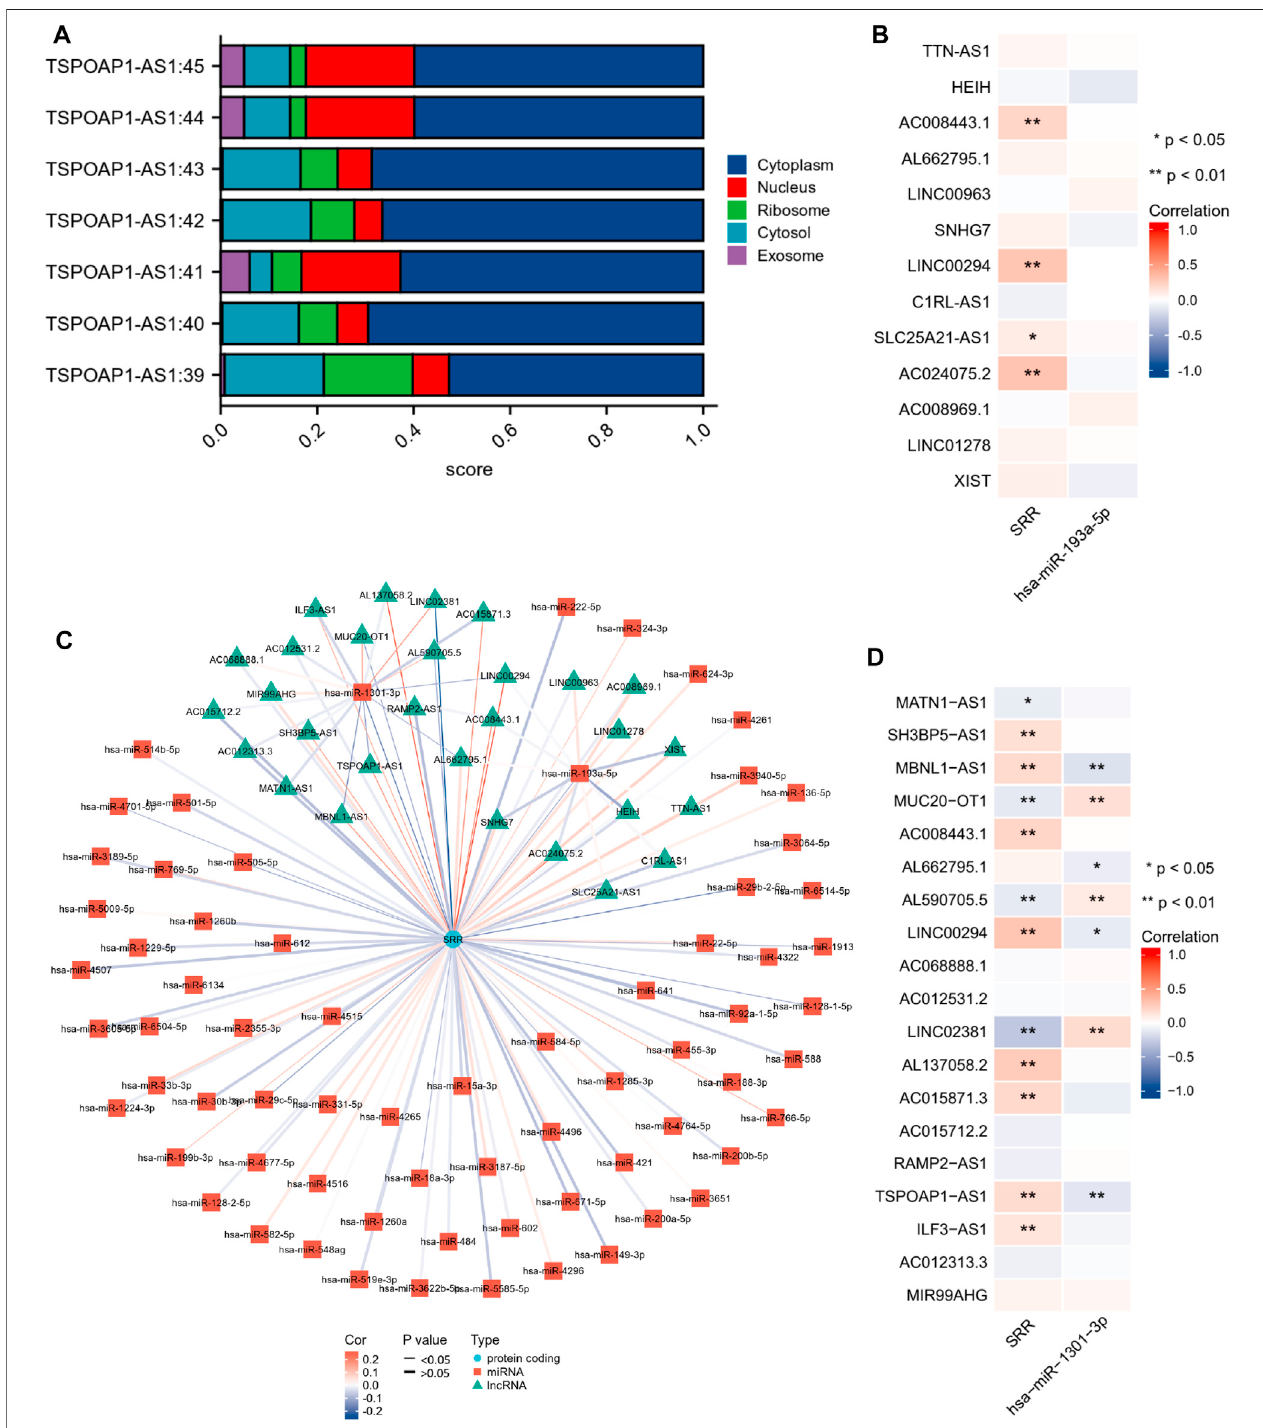
FIGURE 12 | Construction and correlation analysis of the ceRNA network. (A) Cellular localization of seven different transcripts of TSPOAP1-AS1 predicted using LncLocator. (B,D) Expression correlation analysis of the ceRNA network visualized through a heatmap. * p < 0.05, ** p < 0.01. (C) LncRNAs-miRNAs-SRR interaction